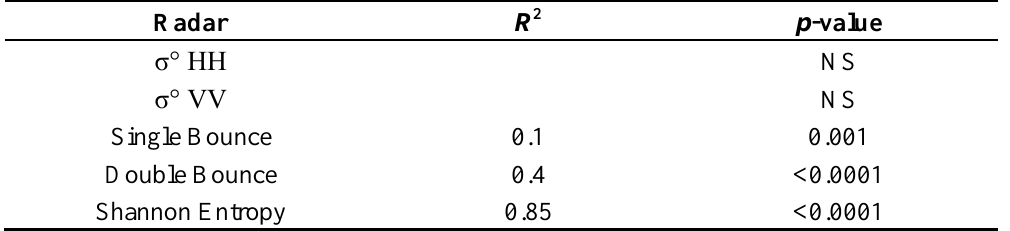
Table 2. Linear regression between the polarimetric parameters and the backscattering coefficients extracted from the SAR image and the heterogeneity structure index extracted from ground surveys.